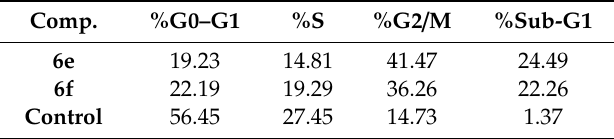
Table 2. E ff ect of compounds 6e and 6f on the cell cycle phases of MCF-7 cells.